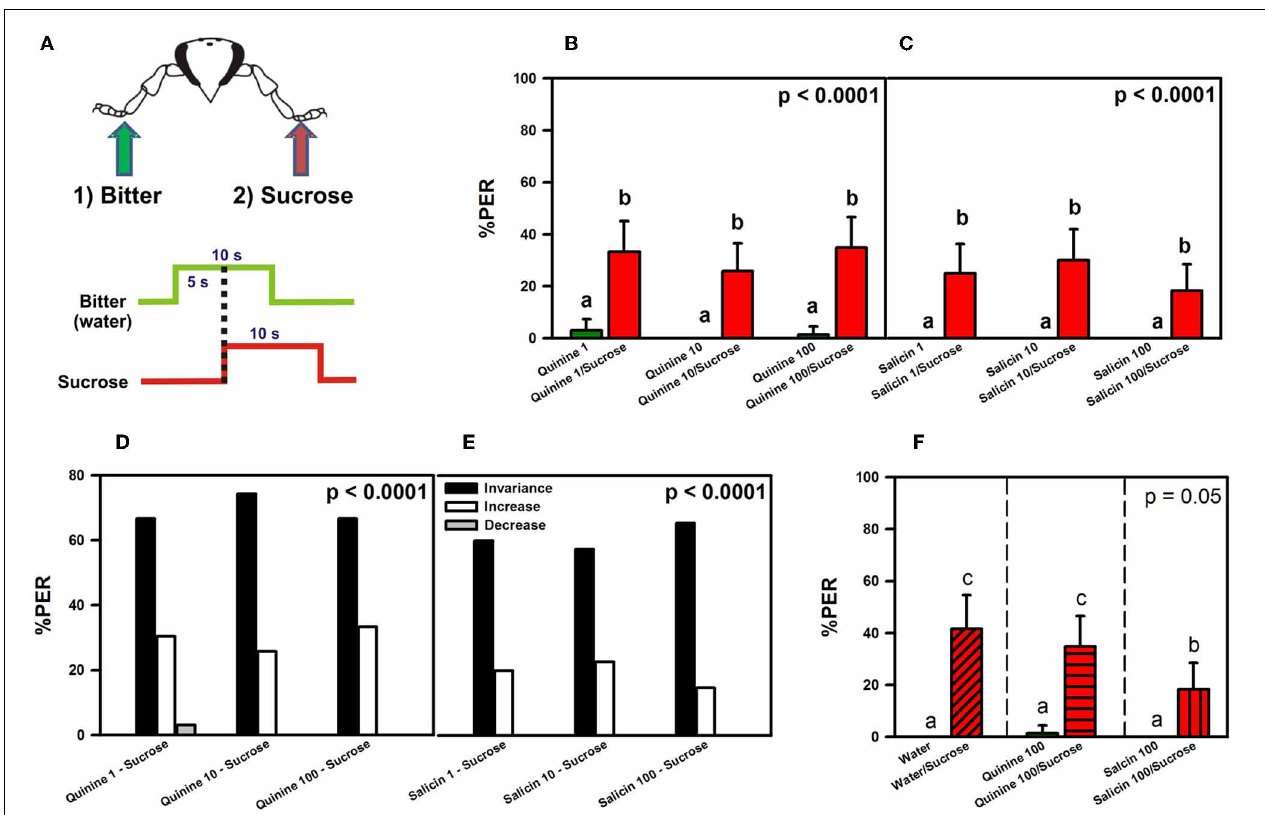
FIGURE 3 | Experiment 2. (A) Bees with amputated antennae were stimulated along three trials with quinine or salicin (“bitter”, green arrow, green trace) of different concentrations on one fore-tarsus, and with sucrose solution 1M (red arrow; red trace) on the contralateral fore-tarsus to determine whether sucrose overcomes the potential inhibitory effect of the bitter substance and elicits PER. (B) % PER upon stimulation with quinine (1, 10, and 100mM; green bars) and sucrose 1M (red bars). (C) % PER upon stimulation with salicin (1, 10, and 100mM; green bars) and sucrose 1M (red bars). Different letters above bars indicate significant differences ( p < 0 . 05).